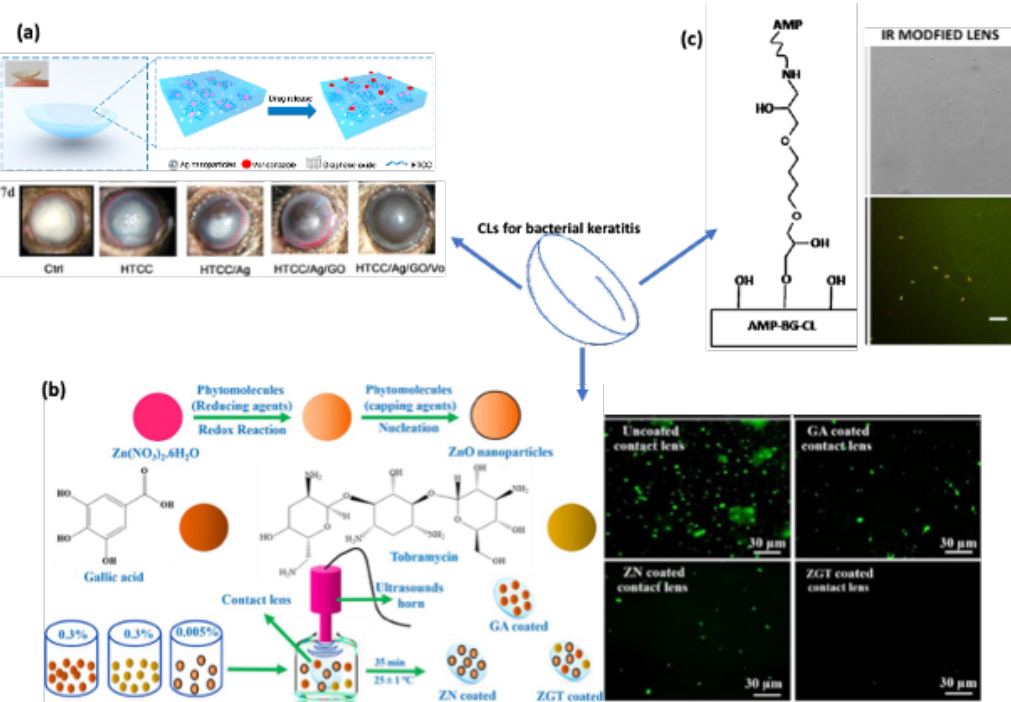
Figure 3. Examples of functional CLs for corneal keratitis. ( a ) Ag NP-embedded CLs. Reproduced with permission of reference [38]. ( b ). ZnO NP-loaded CLs. Reproduced with permission of reference [54]. Scale bars:30 um. ( c ) AMP-coated CLs Reproduced with permission of reference [56]. Scale bars: 10 um.